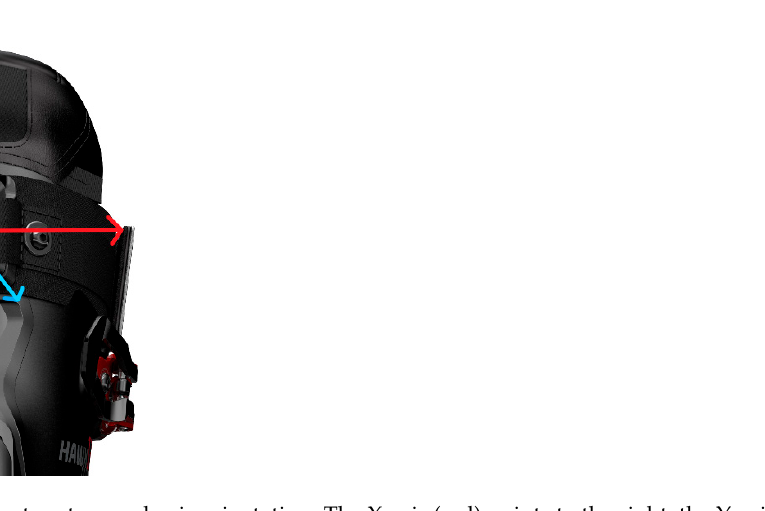
Figure 1. Measurement system and axis orientation. The X axis (red) points to the right, the Y axis (green) points vertically, and the Z axis (blue) points posteriorly.